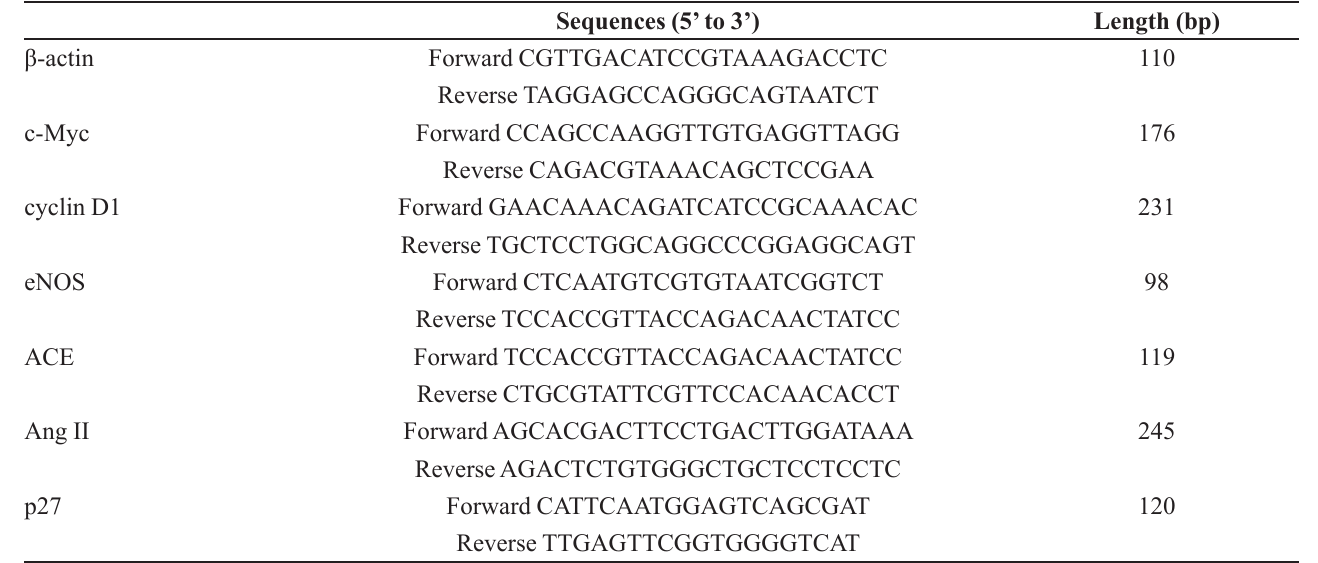
TABLE I - Sequences of polymerase chain reaction (PCR) primer used in real-time